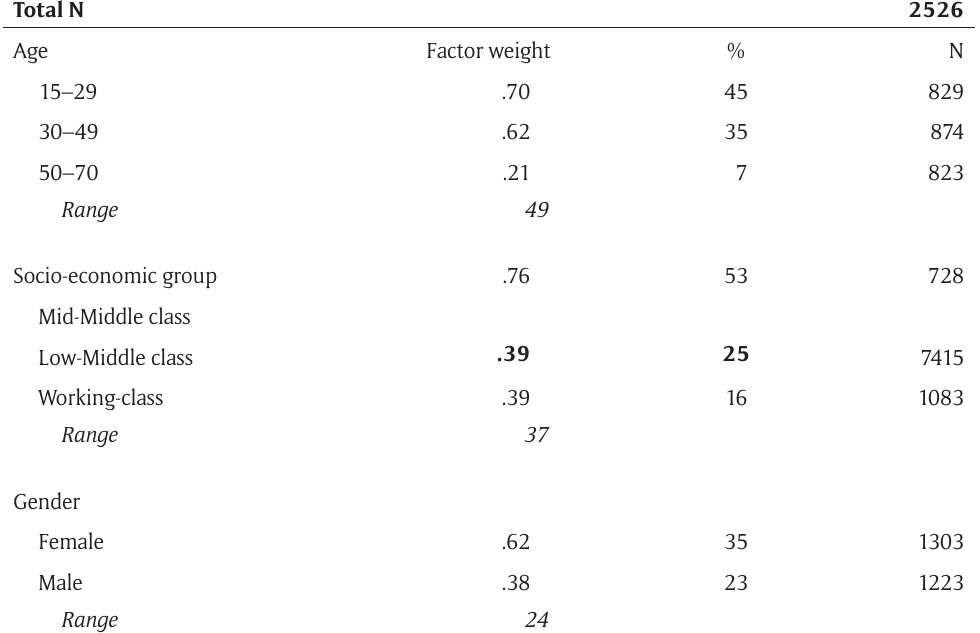
Table 13: Variable rule analyses of the contribution of social factors selected as significant to the probability of palatalization of /ti/, /di/ in UP (2007 data). Note : All extralinguistic factor groups selected as significant.